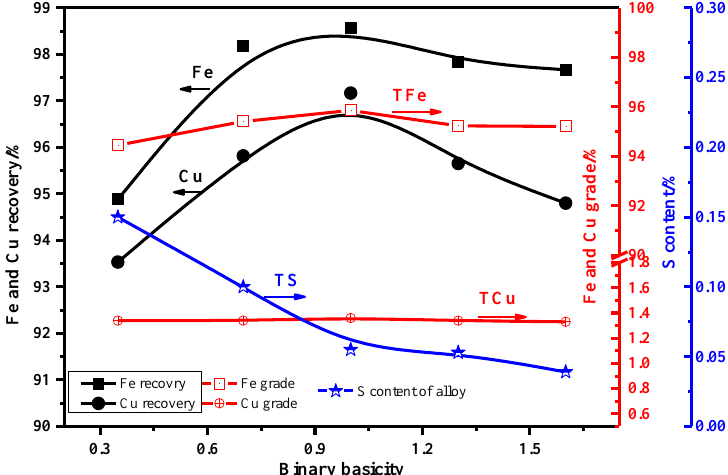
Figure 7. Effect of basicity on Fe and Cu recovery and S removal (Smelting at 1550 °C for 40 min).